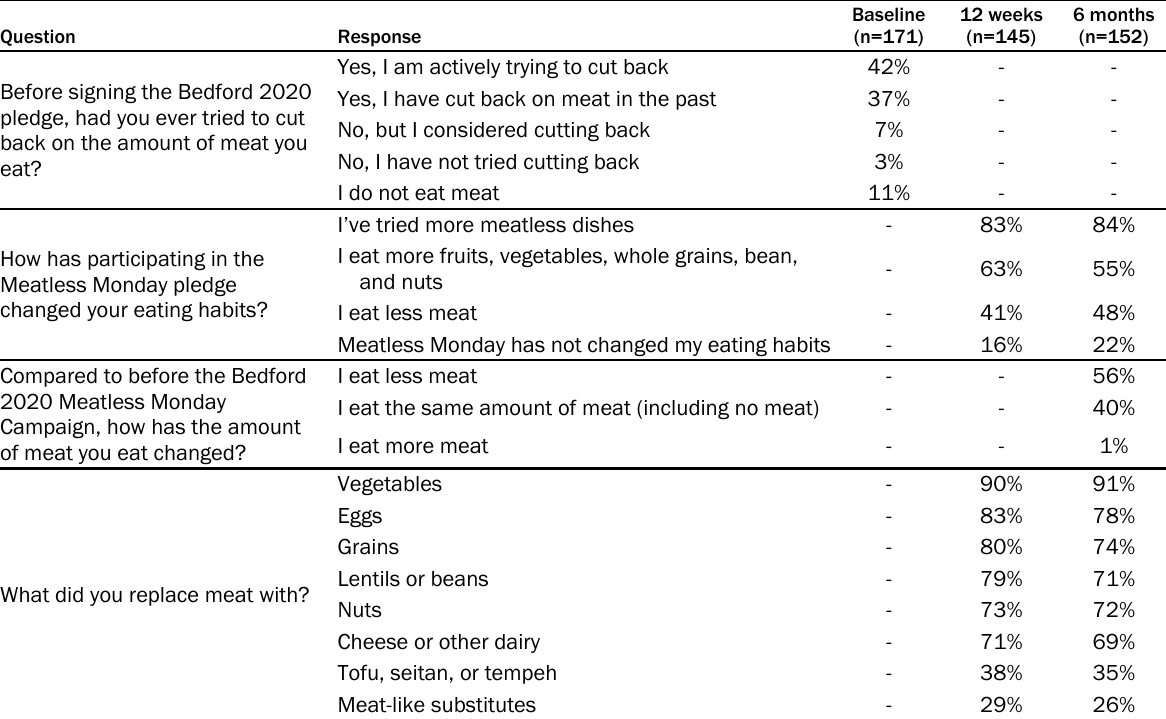
Table 4. Meat Consumption and Behavioral Changes Following the Campaign